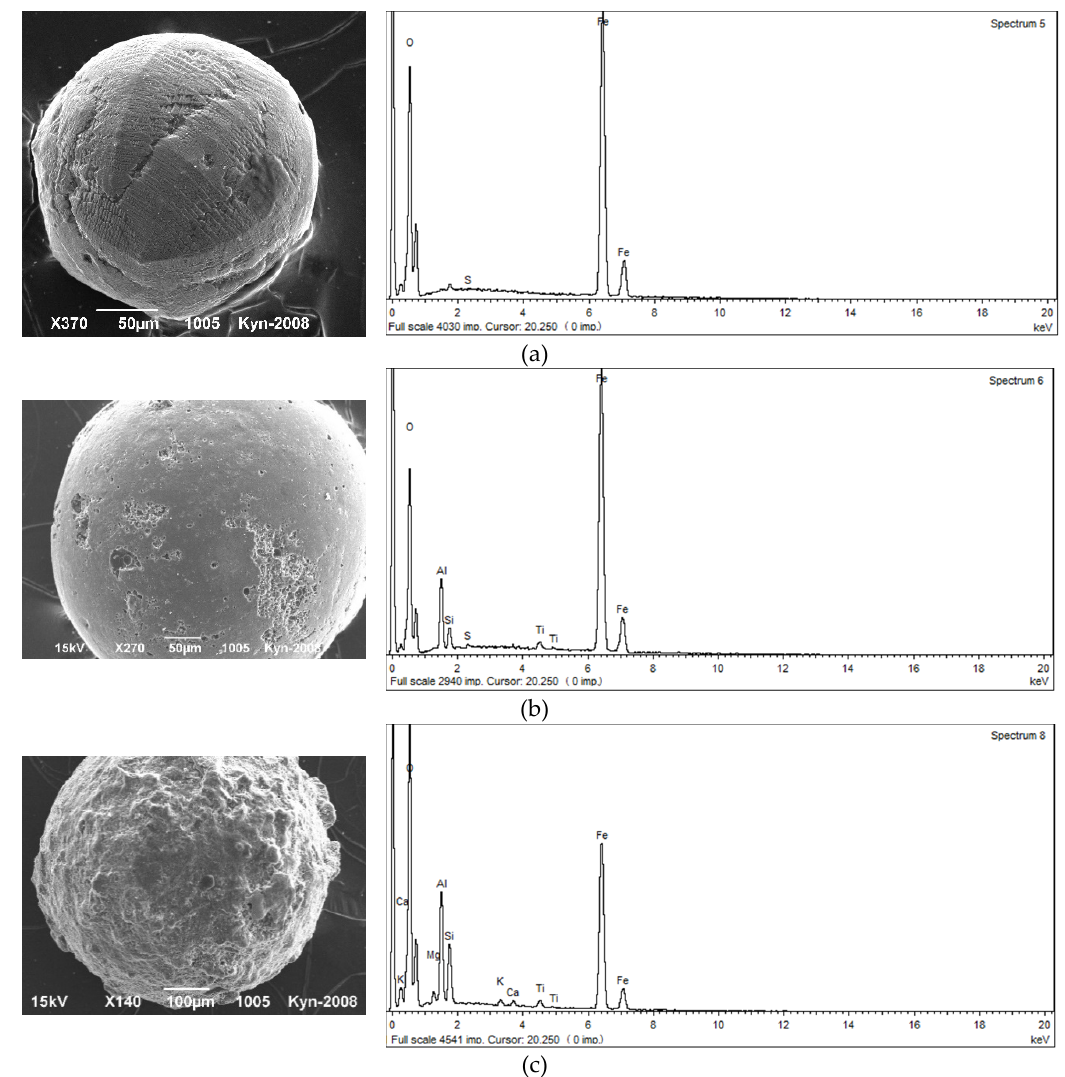
Figure 3. Morphology of typical magnetic spherules: ( a ) tiled microsculpture of the surface with a distinct separation of octants (the Kosva River), ( b ) initial stage of spherula change with separate corroded areas of the surface (the Kizel River), ( c ) stage of a strong spherula change (the Kizel River). Secondary minerals (%) are present in the crystallized part of silty-clayey sediments: goethite — up to 15%, jarosite — up to 45%, basaluminite — up to 8%, lepidocrocite — up to 4%, diaspore and copiapite — up to 2%.